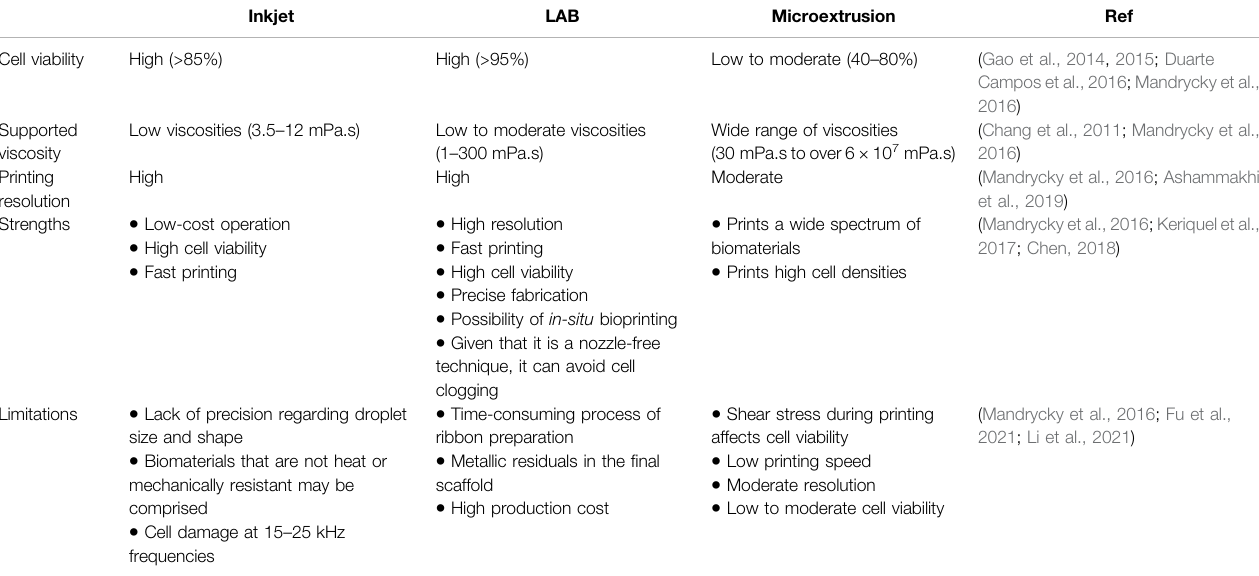
TABLE 3 | Comparison between inkjet, laser-assisted, and microextrusion bioprinting techniques.